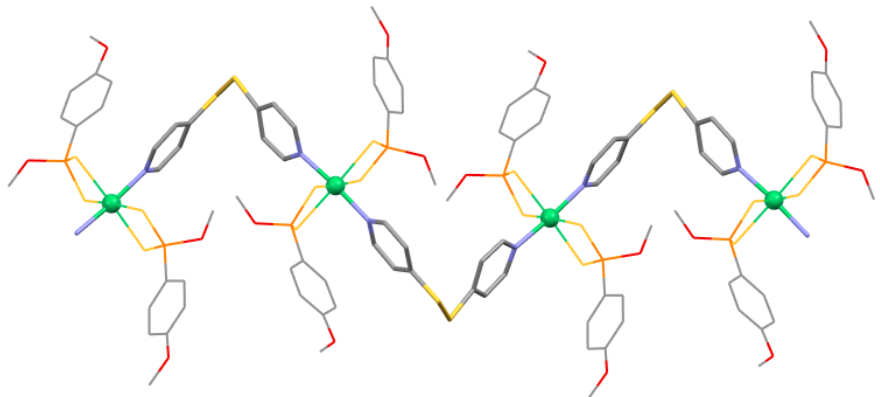
Figure 16. Coordination polymer strand in [Ni(C showing the P form of dtdp